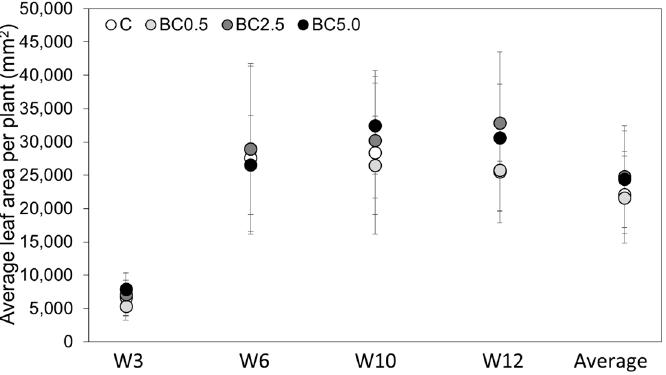
Figure 4. Average leaf areas (mm 2 ) of the pepper plants over time for control and biochar (BC) amended treatments. W represents the weeks after beginning of the experiment. n = 2 to 8; mean ± SD.